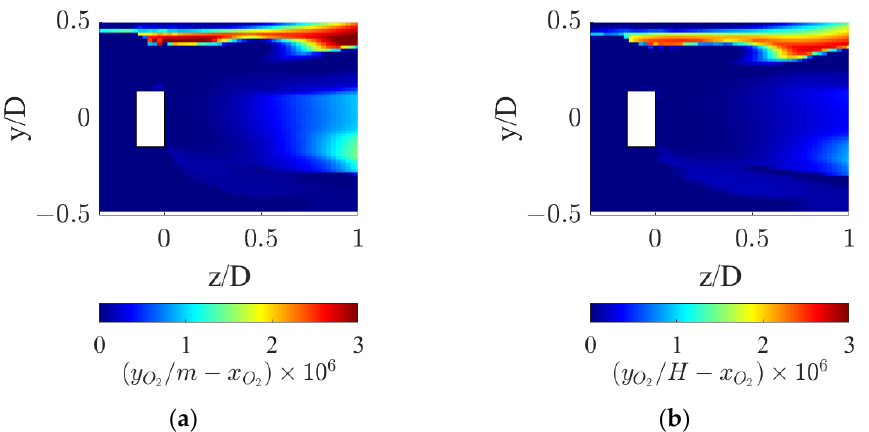
Figure 11. Interphase mass transfer driving force in the proximity of the static mixer for the two operative conditions considered: ( a ) Q L = 25 m 3 /h and Q G = 3.75 L/min and ( b ) Q L = 30 m 3 /h and Q G = 7.5 L/min.